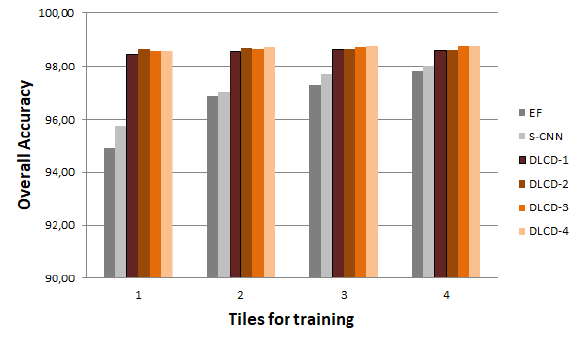
Figure 6. Overall accuracy × number of tiles for